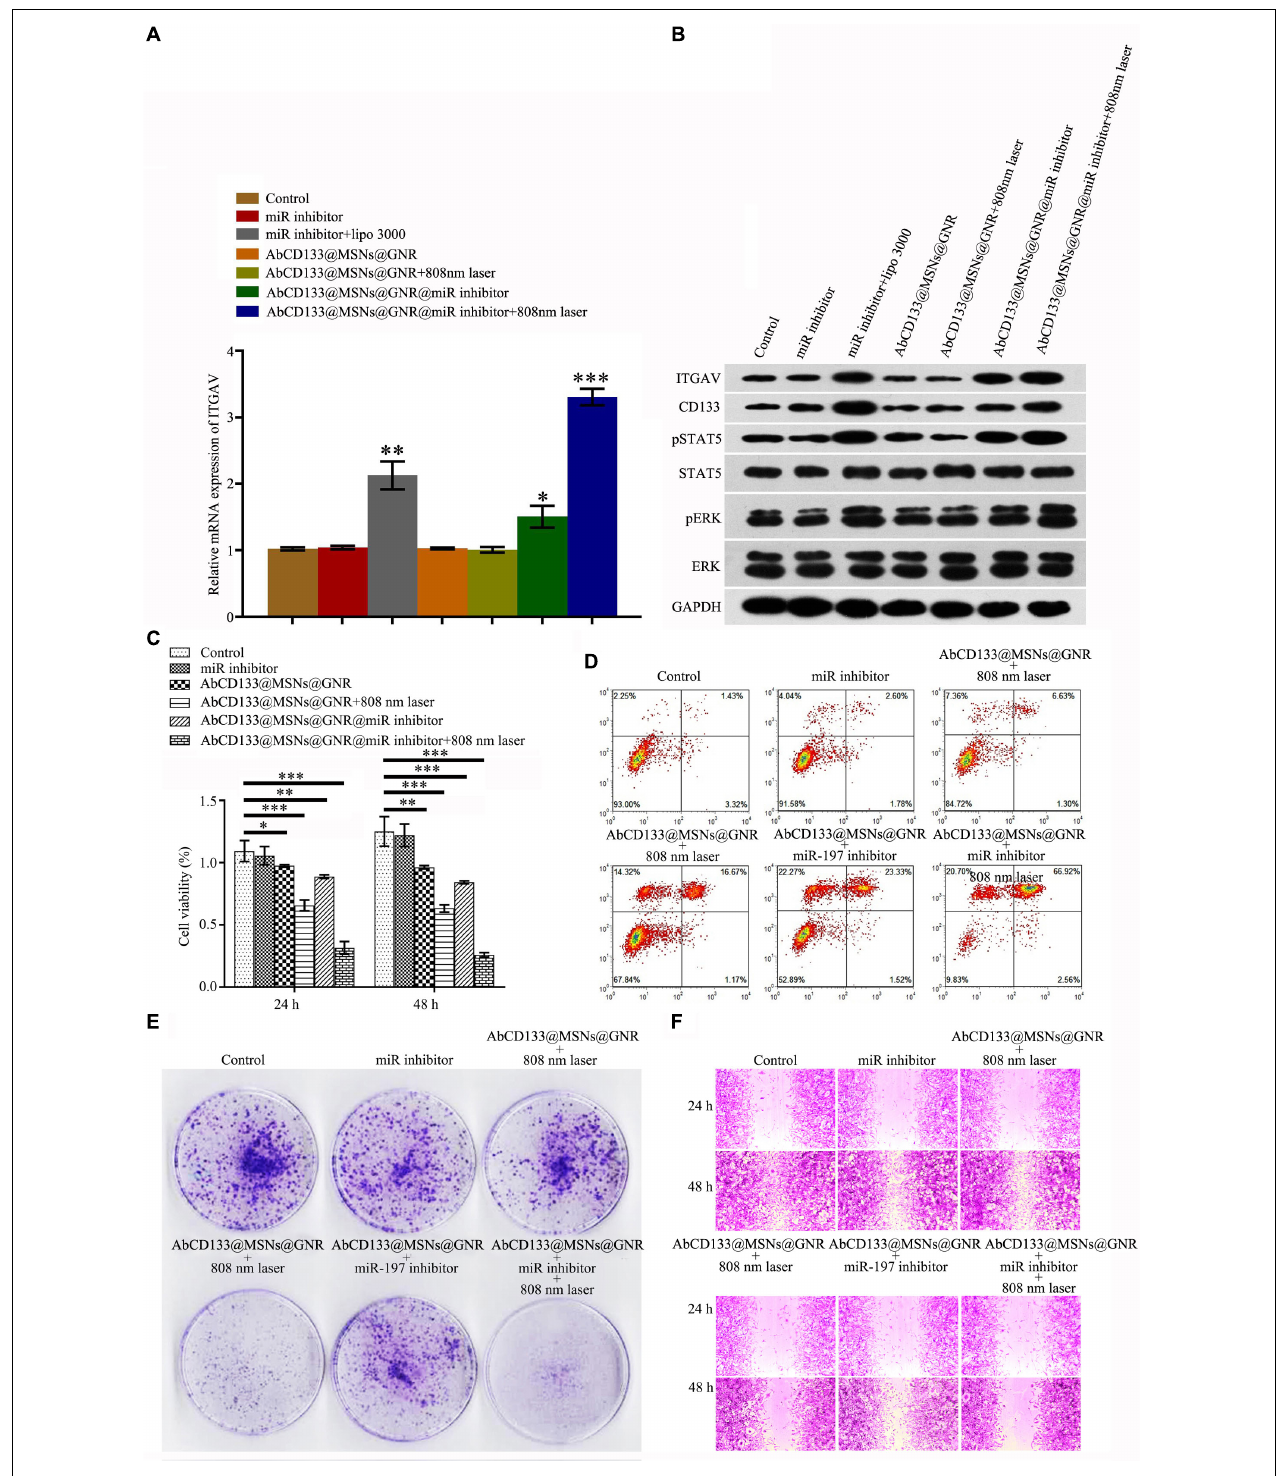
FIGURE 6 | The effect of AbCD133@GNR@MSNs@miR-197 inhibitor on the development of PC3 prostate cancer cells under 808-nm laser irradiation. (A) qPCR assay was used to test the mRNA expression of ITGAV. (B) Western blotting assay was used to test the expression of ITGAV and CD133 and the phosphorylation of STAT5, ERK, and ITGAV-related proteins. (C) Cell Counting Kit-8 (CCK-8) assay was used to test the cell viability of the prostate cancer stem cells (PCSCs). (D) An Annexin V-FITC/PI apoptosis detection kit was used to detect PCSC apoptosis. (E,F) Colony formation experiment and cell scratch assay were conducted to test the cell invasion and infection abilities of the PCSCs. * p < 0.05, ** p < 0.01, *** p < 0.001.